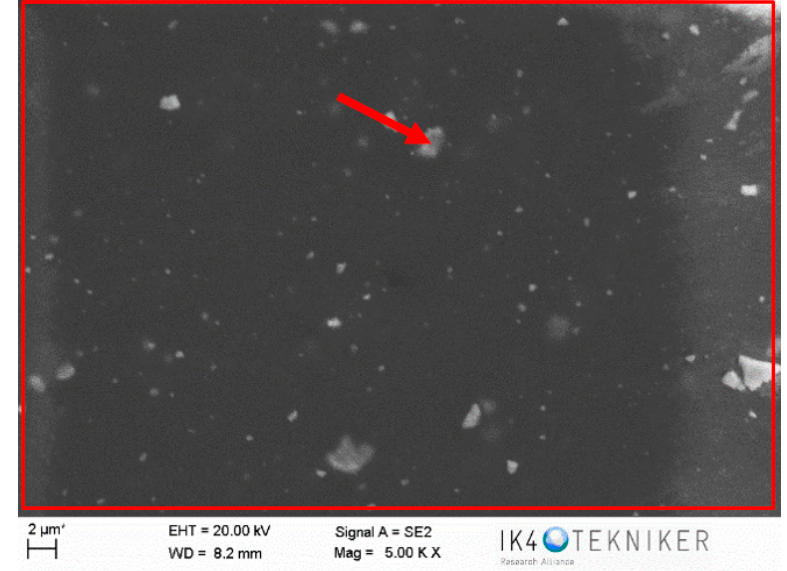
Figure 15. EDS spectrum for zone 1 in a local area marked with an arrow in Figure 13, where ZrO 2 is located. Polymers 2020 , 12 , x FOR PEER REVIEW